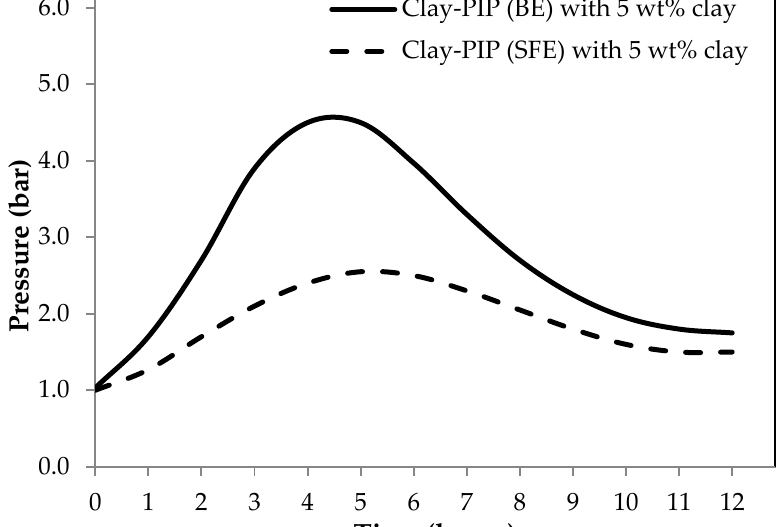
Figure 2. The effect of different emulsion polymerization methods batch (BE) and starve-fed (SFE) techniques, on the particle size of the polyisoprene latexes modified with 5 wt% nanoclay relative to the monomer content.